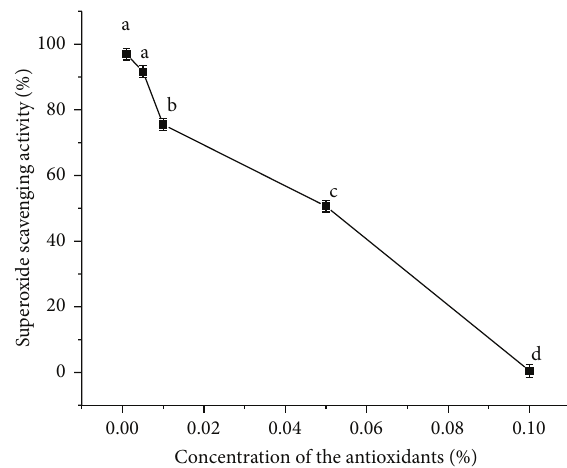
Figure 8: Superoxide scavenging activity by 𝛼 - and 𝛽 -carotene crystals at different concentrations. Values are Mean ± SEM of 3 observations. At the 0.05 level, the difference in superscripts (a, b, c, d) indicates significant difference in